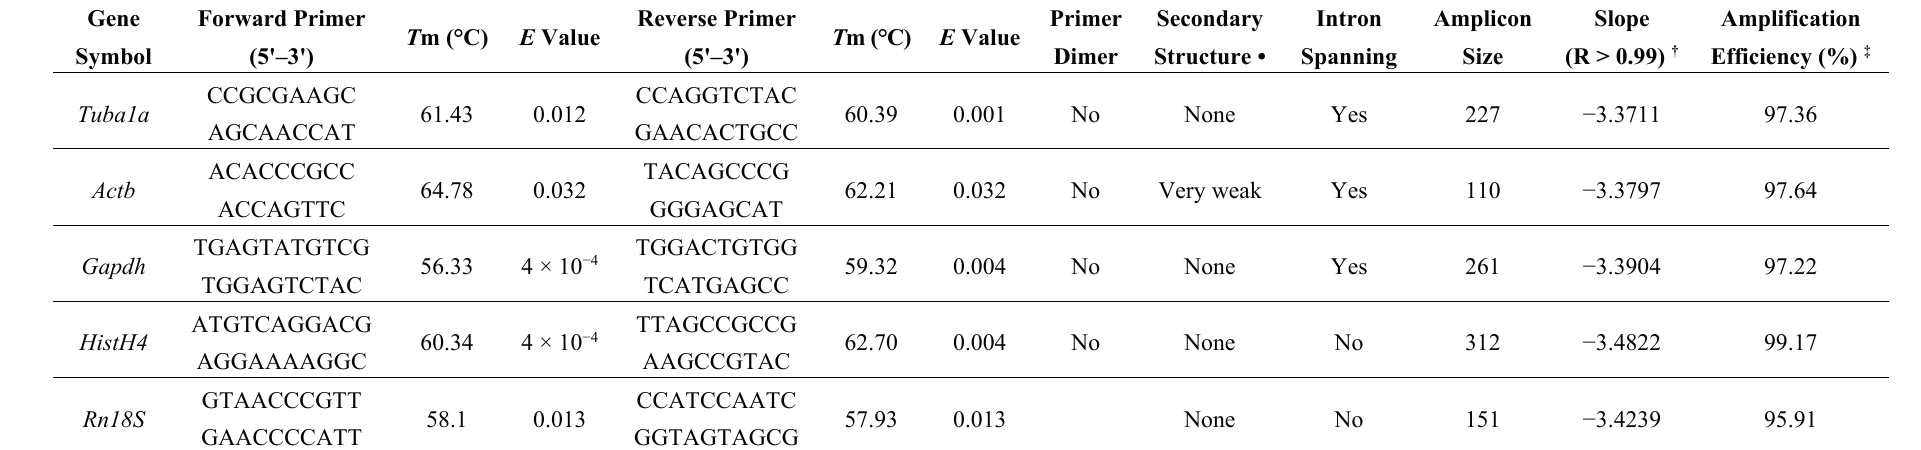
Table 2. Primers for internal control